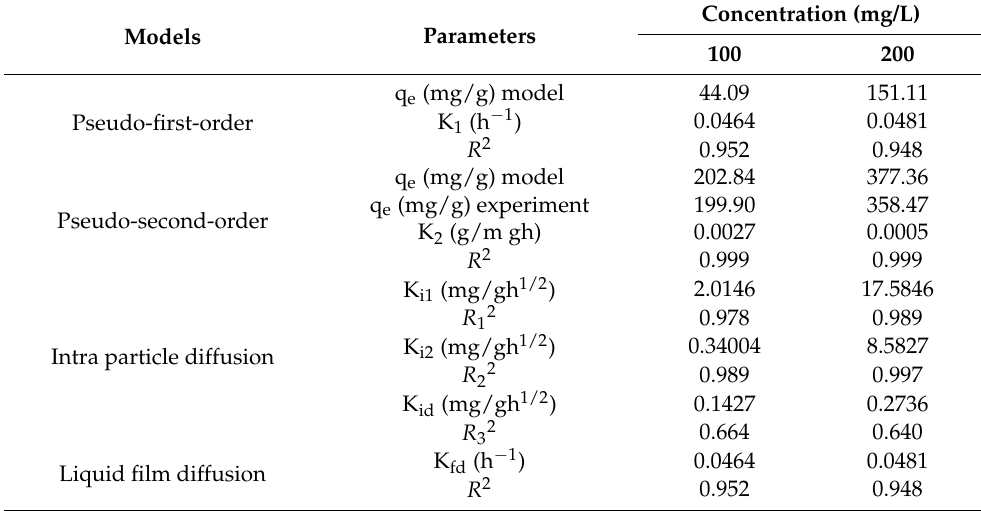
Table 2. Parameters of the four dynamics models.